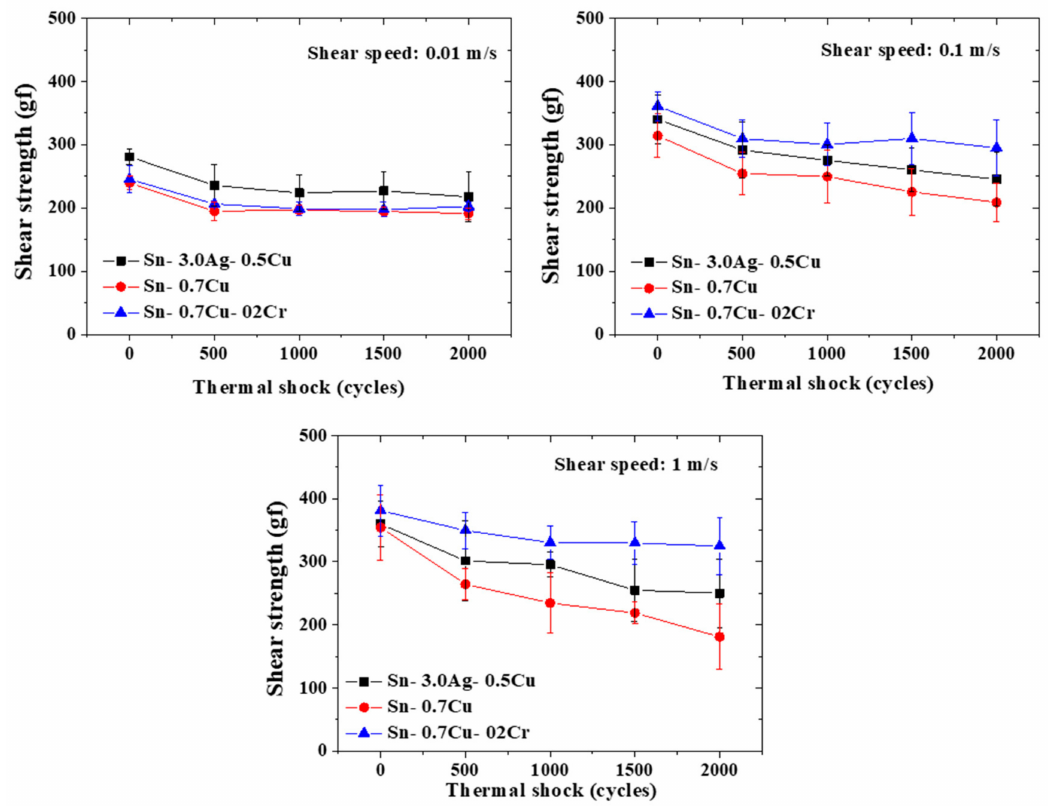
Figure 6. Shear strength of solder joints under various shear